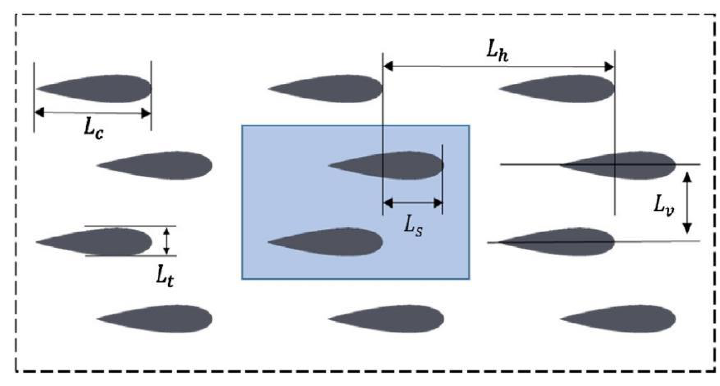
Figure 3. Geometric parameters of the fin arrangement [125].